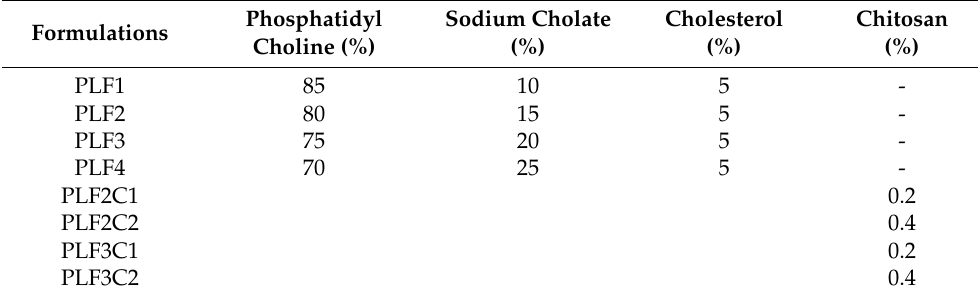
Table 1. Composition of piperine liposome and chitosan coated piperine liposomes.